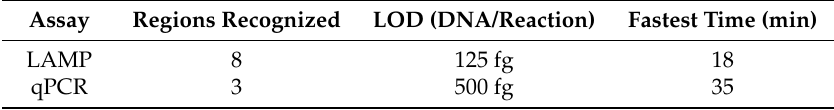
Table 1. The limit of detection (LOD) and time for LAMP and qPCR detection of B. quintana groEL. Assay Regions